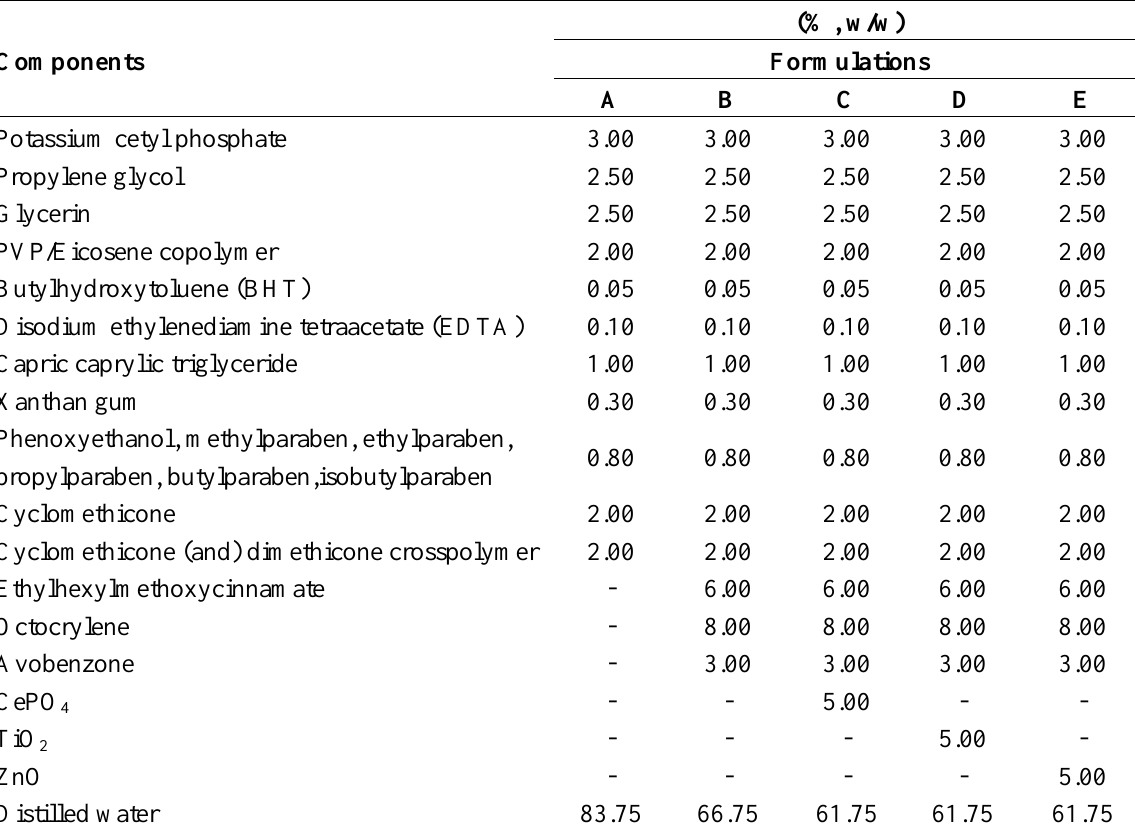
Table 3. Components of the formulation under